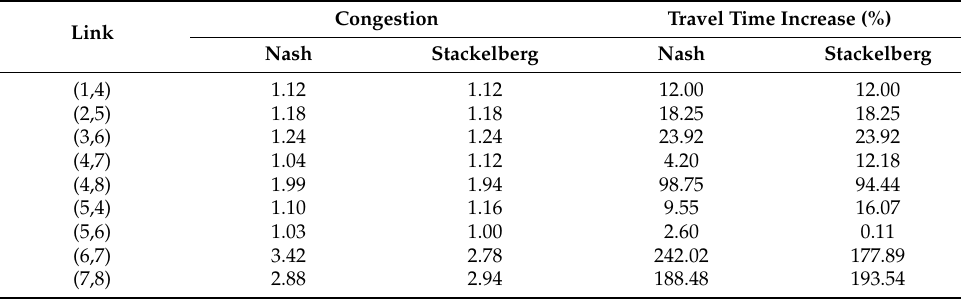
Figure 6. Compared travel times through individual links to road network for scenario #1. Table 5. Traffic congestion in transport network links for scenario